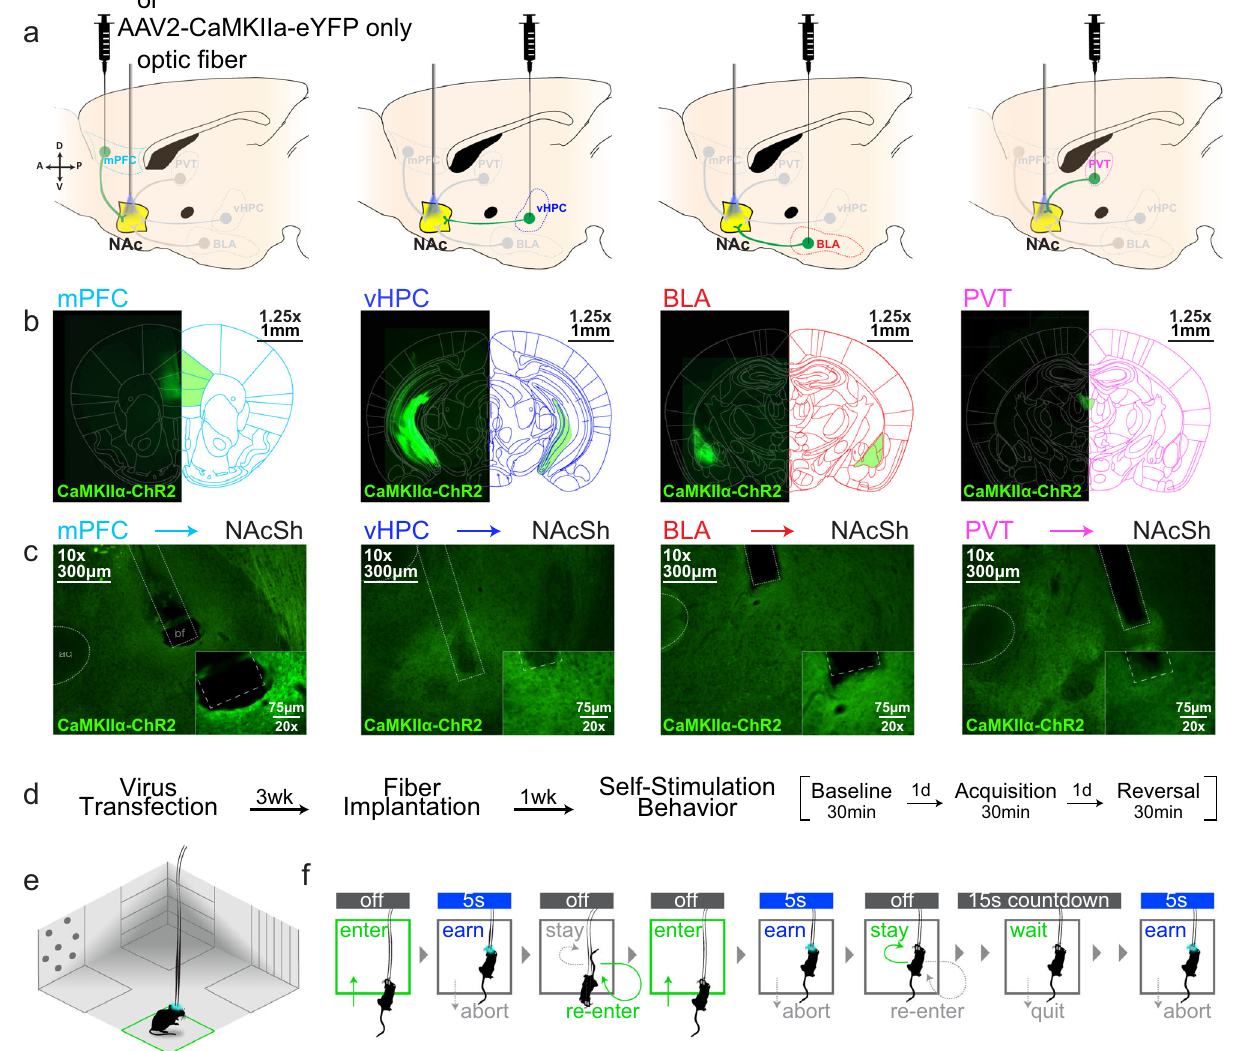
Fig. 1 Neural pathway targets and optogenetic self-stimulation behaviour task. a Viral vector injections and optic fi ber implants targeted speci fi c excitatory inputs to the NAcSh. b Representative images (4x) from coronal slices (40 µ m) showing viral localization and spread. c Representative images of input-speci fi c ChR2 + terminal regions in NAcSh (10x, insets at 20x). The optical fi ber (of) and anterior commissure (ac) are depicted with straight and rounded dashed lines, respectively. d Experimental timeline. Each session was 30 min long with one session per day. e Optogenetic stimulation was inactive during baseline, active in one zone during acquisition, and active in a different zone during reversal (30 Hz, 5 ms pulse width, 5 s max stimulation per bout). f Illustration of reward-related decisions during the task. A mouse could exit and re-enter the active zone to bypass a 15 s “ timeout ” period,